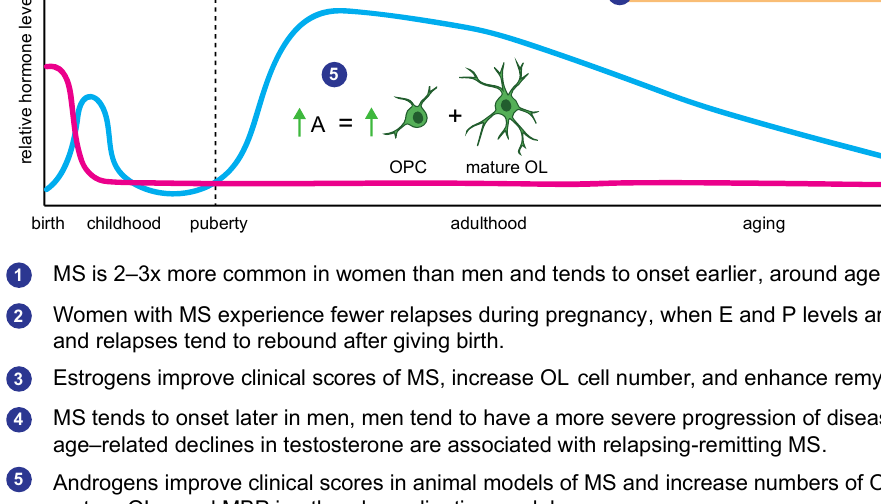
Figure 2. Summary of sex hormone changes across development and their relationship with demyelinating disorders, oligodendrogenesis, and remyelination. Dashed line = puberty onset. E = estrogens, P = progestogens, A = androgens.